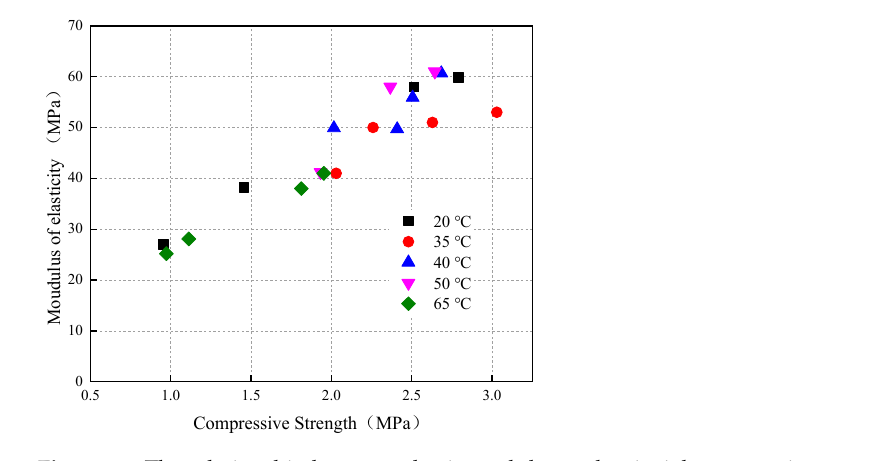
Figure 18. The relationship between elastic modulus and uniaxial compressive strength at different curing temperatures.